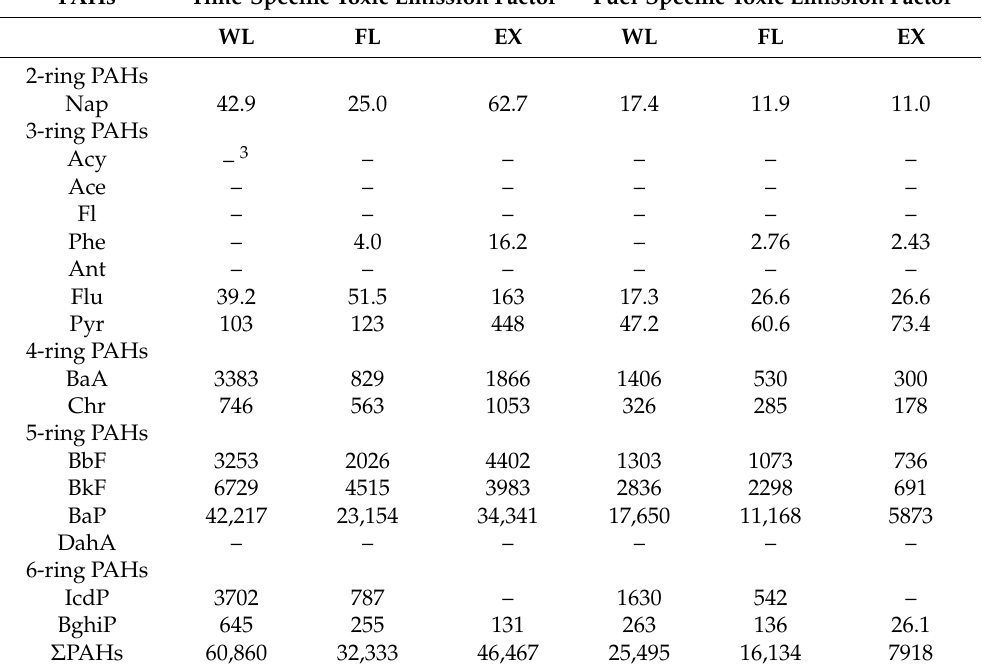
Table 4. Time- and fuel-specific toxic potency emission factors of PAHs for different types of con- struction